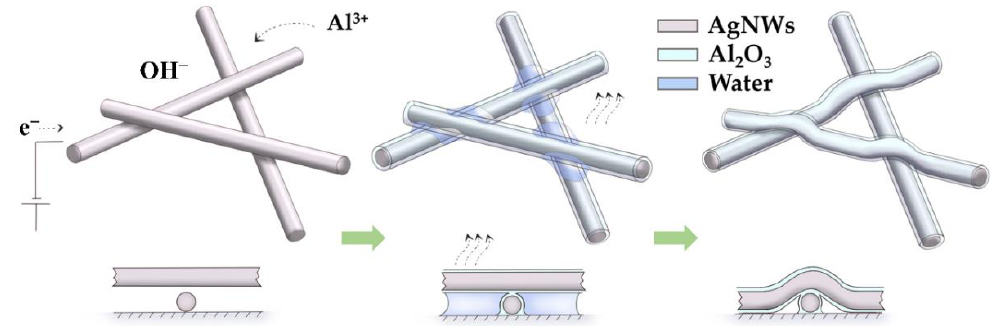
Figure 10. Schematic of the process of Al 2 O 3 electrodeposition on AgNWs.